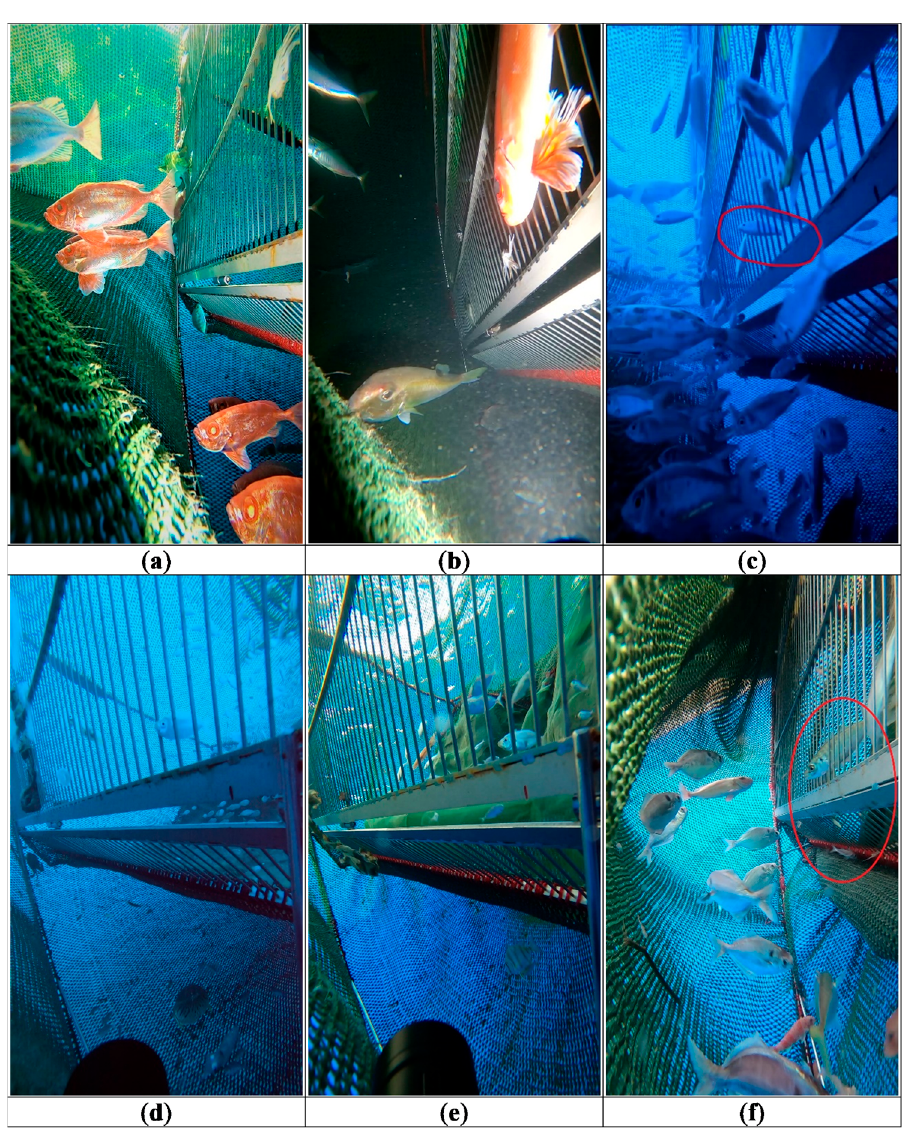
Figure 8. ( a – f ) Underwater photographs depicting fish